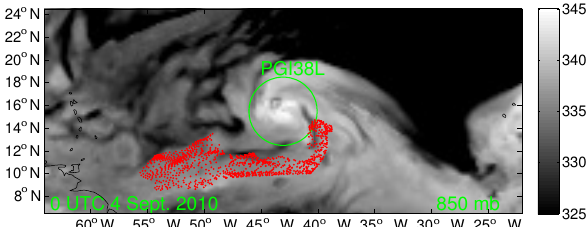
Figure 11. Particle trajectory locations at 850hPa at 00:00UTC 4 September overlaid on θ e (K). Particles were seeded west of ex- Gaston’s pouch at 12:00UTC 2 September, within a suspected trade wind inversion layer. These trajectories are all outside of a 3 ◦ radius of the pouch center (green circle) on 4